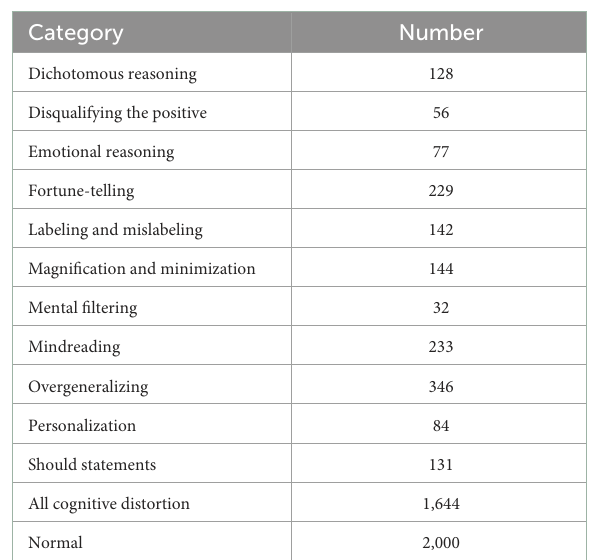
TABLE 5 Main statistics of cognitive distortion dataset after semi-supervised.